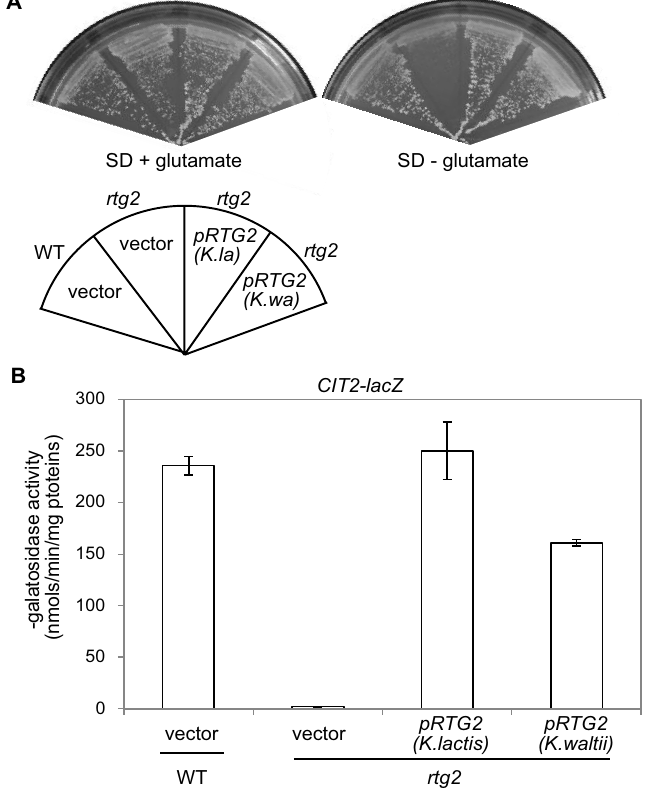
Figure 3. The Rtg2 homologs from K. lactis and K. waltii are functional in S. cerevisiae. ( A ) RTG2 homologs complement glutamate auxotrophy phenotype of rtg2 (cid:39) in S. cerevisiae. Wild-type (WT, PSY142) and rtg2 (cid:39) (PSY142-rtg2) mutant cells carrying empty vector or centromeric plasmids encoding RTG2 genes from K. lactis ( K.la ) and K. waltii ( K.wa ) were grown on SD medium with or without glutamate at 30 °C for 2 (cid:177) 3 days. ( B ) Expression of RTG2 homologs restores expression of a CIT2-lacZ reporter